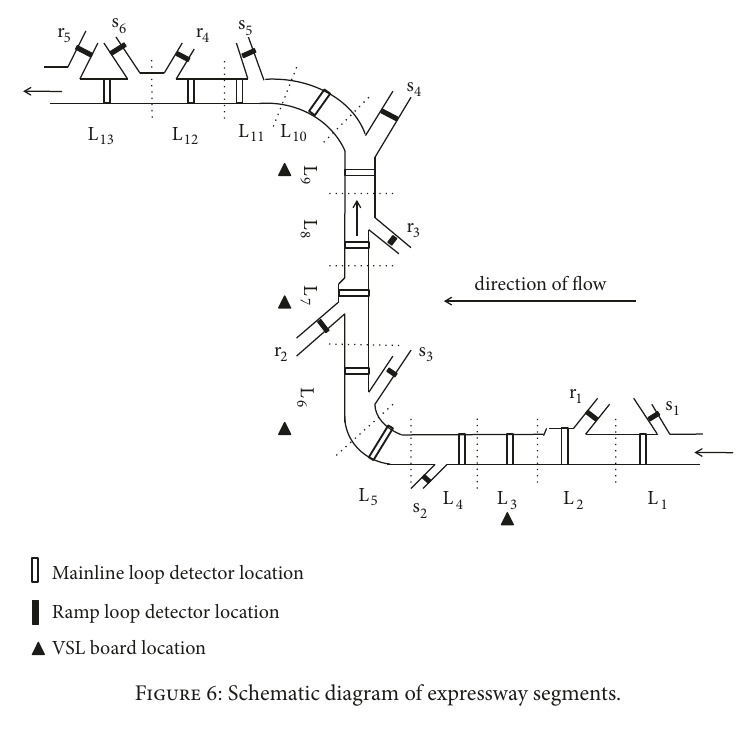
Figure 6: Schematic diagram of expressway segments.